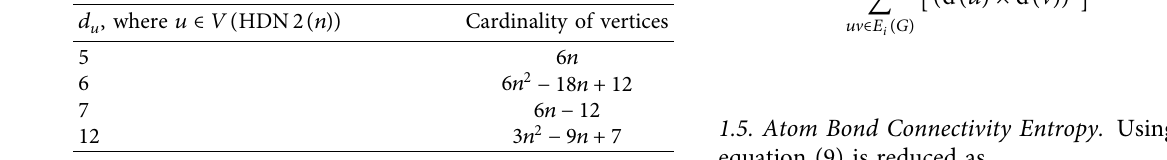
Figure 3: Hex-derived network HDN2 ( 4 ) Table 3: Vertex partition of HDN2 ( n ) .